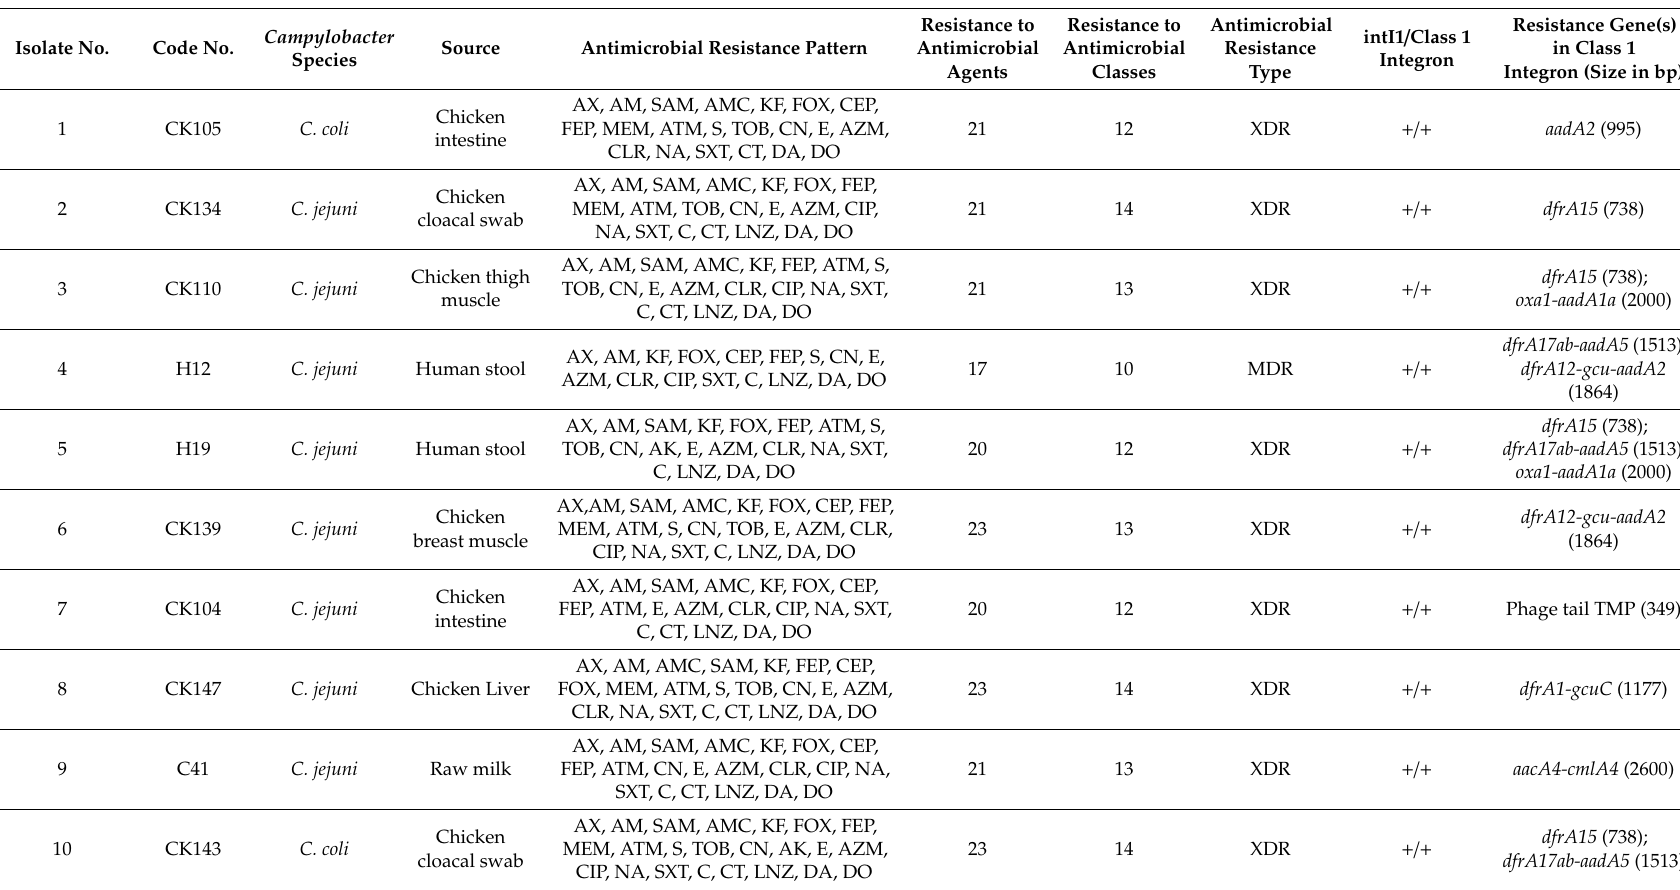
Table 4. Antimicrobial resistance patterns and gene cassette arrays carried by class 1 integrons in MDR, XDR and PDR Campylobacter isolates recovered from di ff erent sources ( n =